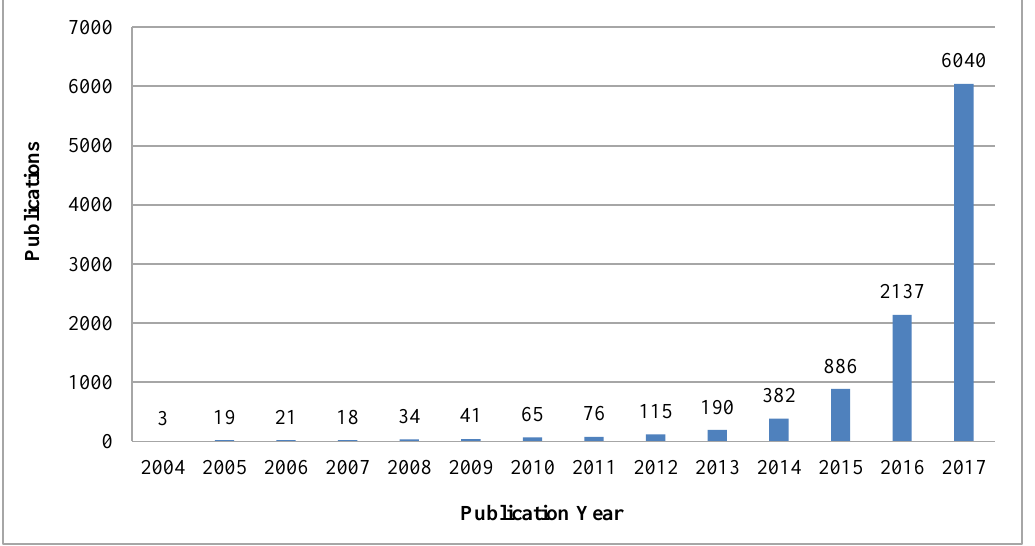
Figure 1. Publications Trend in Deep Learning Research